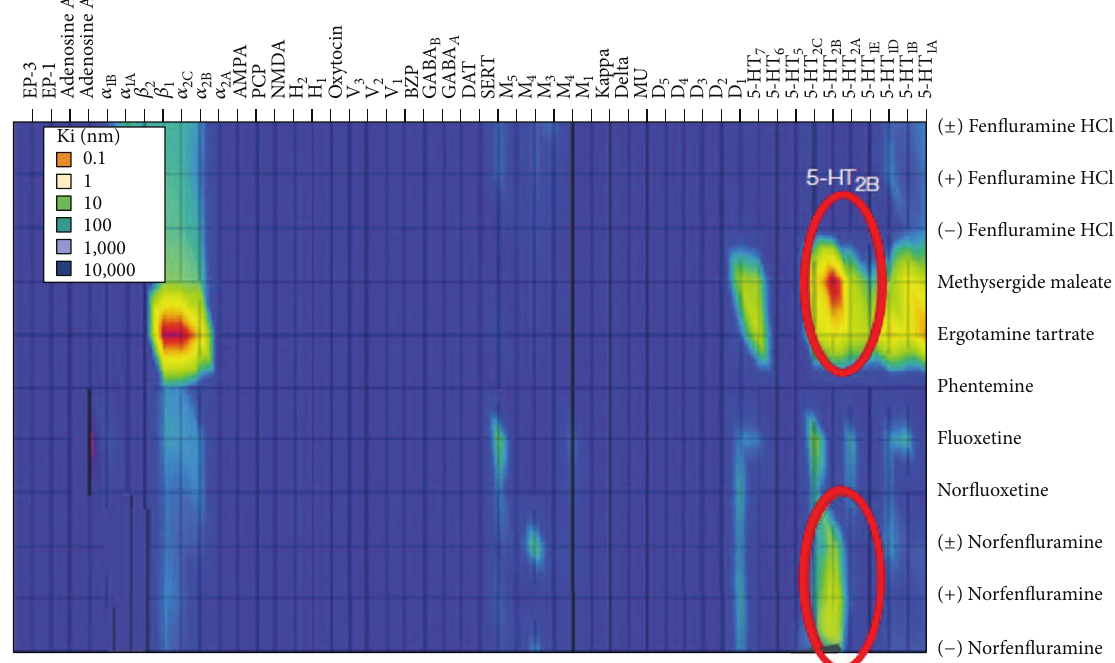
Figure 2: The molecular targets for cardiopulmonary-associated drugs. Recetoromic screening revealed the molecular targets implicated in fenfluramine. 5-HT2B serotonin receptor was identified as a molecular target for the norfenfluramine (a metabolite of fenfluramine), methy- lergonovine (a metabolite of the valvular heart disease- and pulmonary hypertension-associated drug methysergide), and dihydroergotamine (potentially associated with valvular heart disease and pulmonary hypertension). The drugs associated with cardio diseases also show high affinity to 𝛼 -2B adrenergic receptors, whereas fluoxetine and the metabolite norfluoxetine do not. In this heat map, the affinity of the drugs is mapped by color gradient, that is, blue (lower affinity, higher Ki), red (higher affinity, lower Ki), and intermediated color (reprinted with permission from Nature Publishing